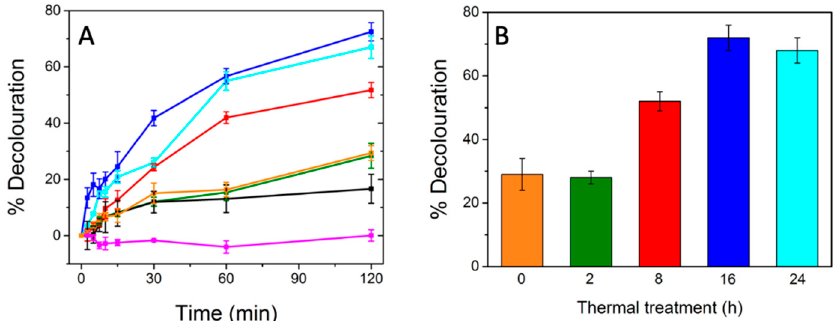
Figure 9. Panel ( A ) Time course evolution of methylene blue (MB) decoloration at pH 6, under UV irradiation, assisted by TiO 2 _0 h (orange line), TiO 2 _2 h (green line), TiO 2 _8 h (red line), TiO 2 _16 h (blue line), TiO 2 _24 h (light blue line). Experiments were evaluated by monitoring the MB absorbance intensity at 664 nm. Control experiments in absence of photocatalyst (violet line) and at dark (black line) are reported. Experimental data are presented as mean values ± standard deviation obtained from the analysis of five replicates. Panel ( B ) Histogram chart showing the percentage of MB decoloration after 120 min of UV irradiation at pH 6 as a function of thermal treatment time the TiO 2 NPs. MB concentration: 1 × 10 − 5 M. Experimental data are presented as mean values ± standard deviation obtained from the analysis of five replicates.